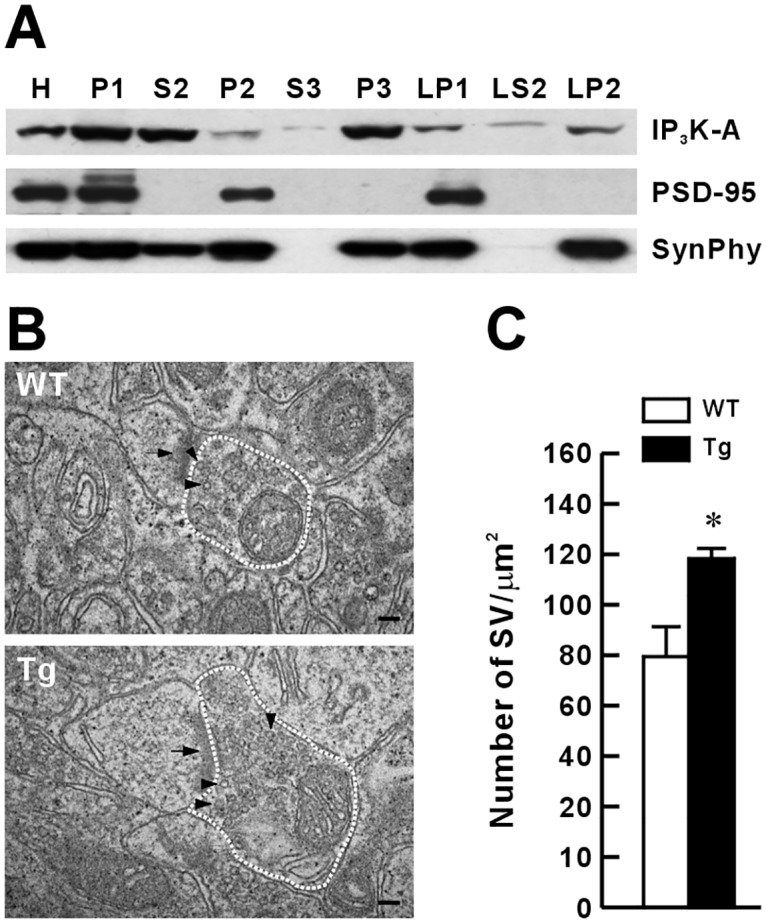
Subcellular localization of IP3K-A and increased number of synaptic vesicles in IP3K-A Tg mice.(A), Distribution pattern of IP3K-A in the adult mouse brain subcellular fractions. PSD-95 and synaptophysin (SynPhy) were used as controls. H, homogenates; P1, nuclei and large debris; P2, crude synaptosomes; S2, supernatant after P2 precipitation; S3, cytosol; P3, light membranes; LP1, synaptosomal membranes; LS2, synaptosomal cytosol; LP2, synaptic vesicle-enriched fraction. (B), Representative EM images of hippocampal CA1 synapses in WT and Tg mice. Scale bar: 100 mm. (C), Quantification of the number of synaptic vesicles per area (WT, n = 60 synapses, 3 mice; Tg, n = 60, 3). Presynaptic terminals with well-defined postsynaptic density (arrows) were chosen for analysis. Dashed lines indicated the presynaptic area for the analysis of synaptic vesicle (arrowheads) density per area.